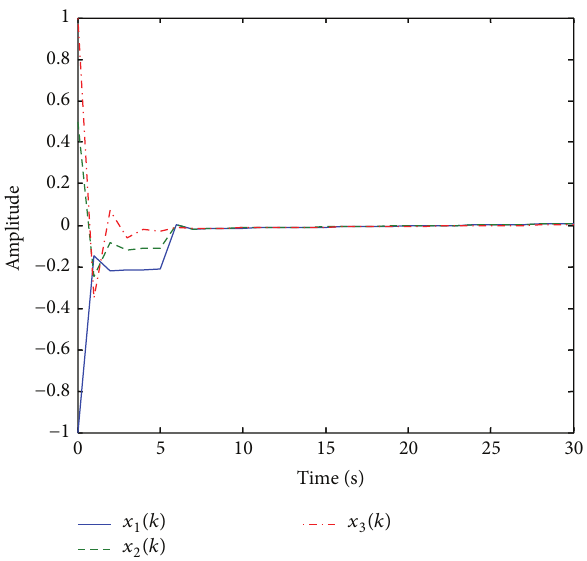
Figure 1: State trajectories of the system.